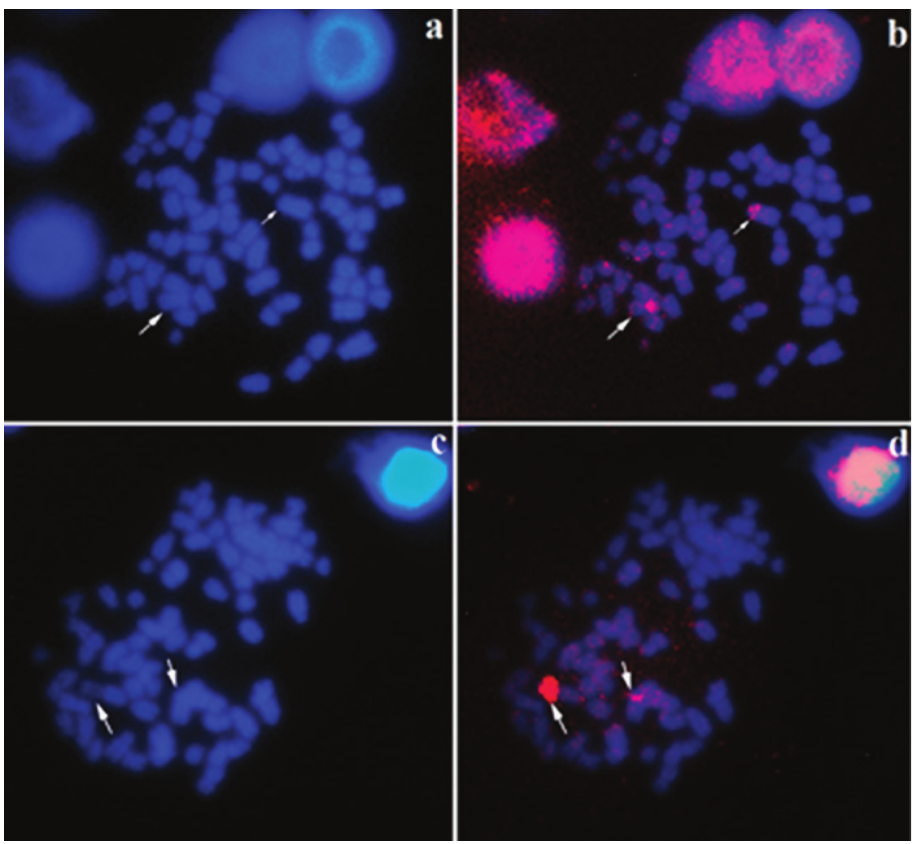
Figure 3. Metaphases of Hypostomus regani after FISH with the HrV probe: karyomorph A ( a, b ) and karyomorph B ( c, d ) a DAPI stained metaphases of karyomorph A and the arrows indicate pair 19 b merged image of metaphase showing intense fluorescent signals positive for HrV probe in the pair 19 (arrows) c DAPI stained metaphases of karyomorph B and the arrows indicate heteromorphic pair 19 d merged image of metaphase showing intense fluorescent signals positive for HrV probe in the hetero- morphic pair 19 (arrows). Scale bar: